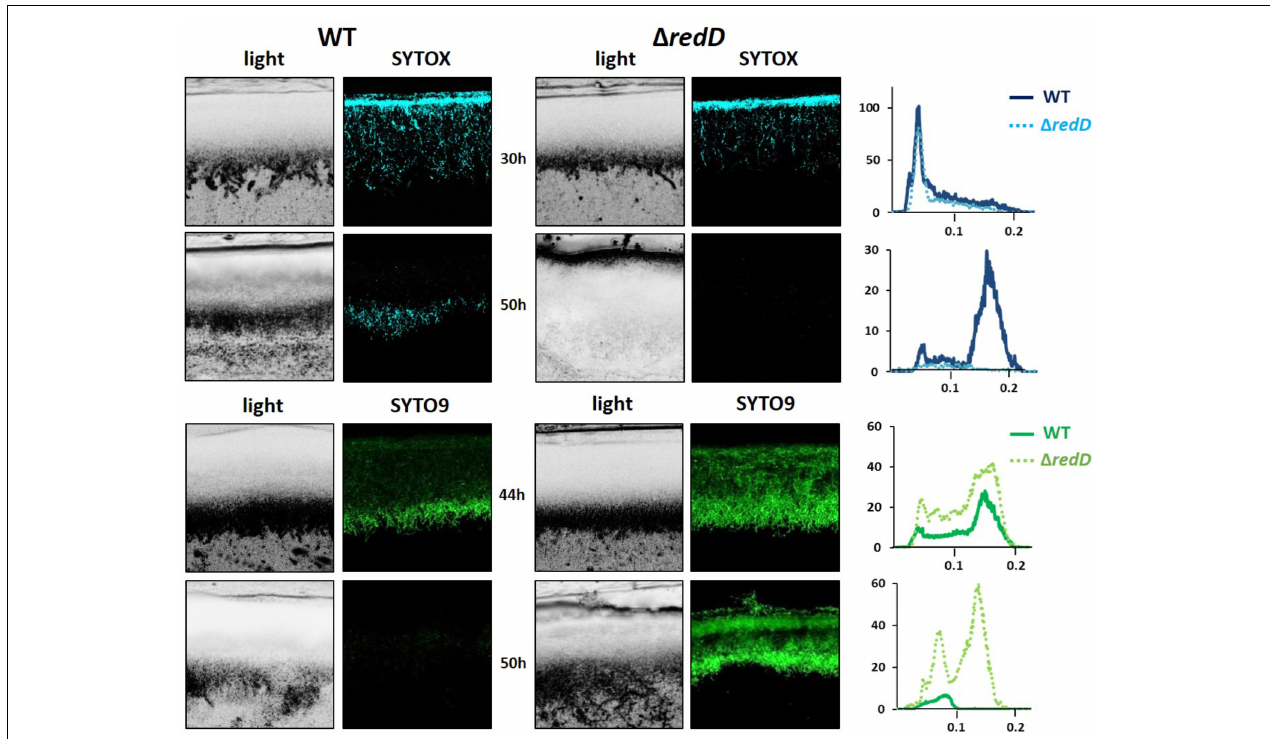
FIGURE 5 | Prodiginine biosynthesis causes massive loss of viable filaments. SYTOX (blue) and SYTO9 (green) staining of cross sections of culture of S. coelicolor M145 (wild-type, WT) and its redD null mutant inoculated in R2YE agar plates. Bars, 40 µ m. Note that (i) the PCD round prior to PdG production also occurs at 30 h in the redD null mutant of S. coelicolor , and (ii) the higher accumulation of viable filaments (only stained by SYTO9) in the redD mutant. Quantification of the SYTOX and SYTO9 fluorescence signals are displayed in plots next to the microscopy